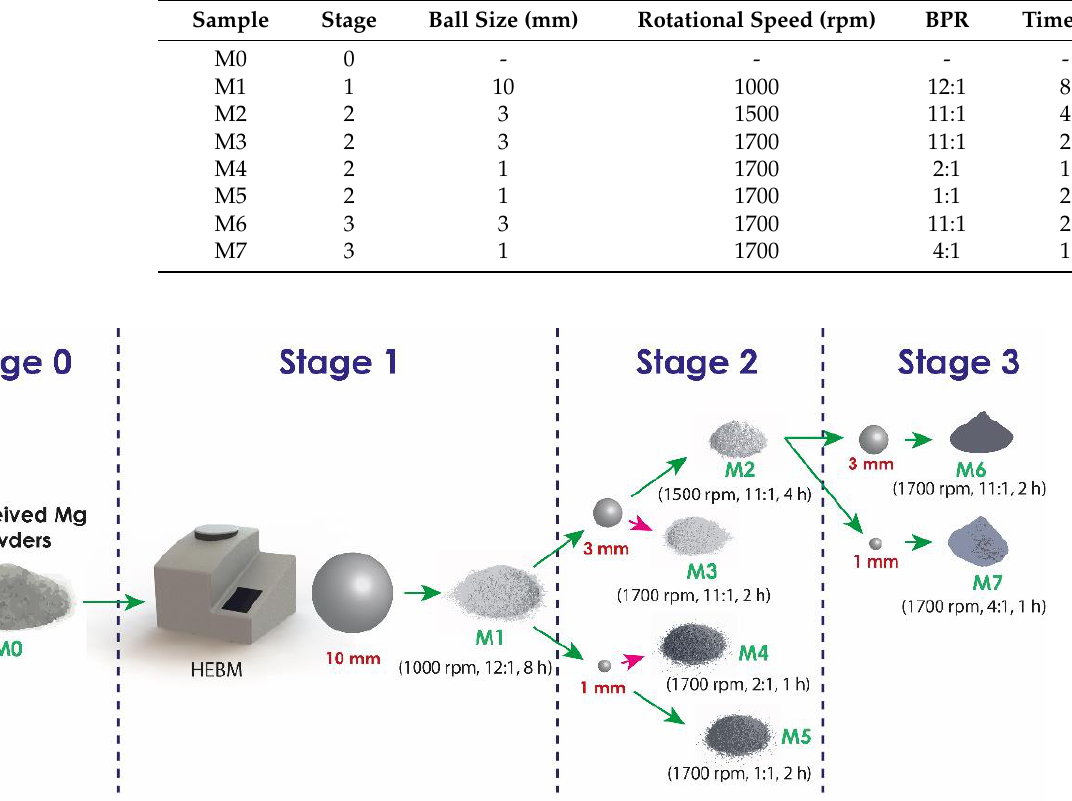
Figure 2. Schematic representation of the process stages.